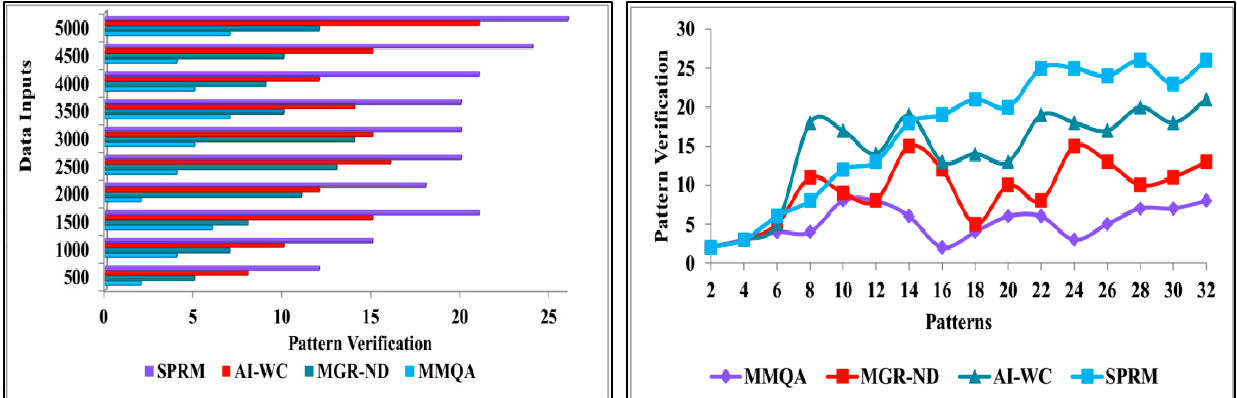
Figure 12. Pattern verification